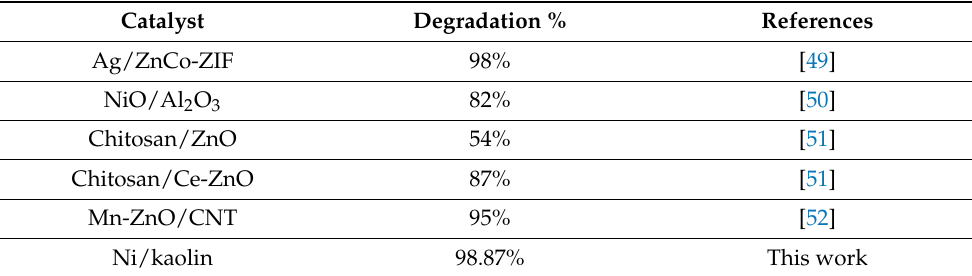
Table 3. Comparison of the percentage degradation of MG dye by supported catalysts reported in the literature.